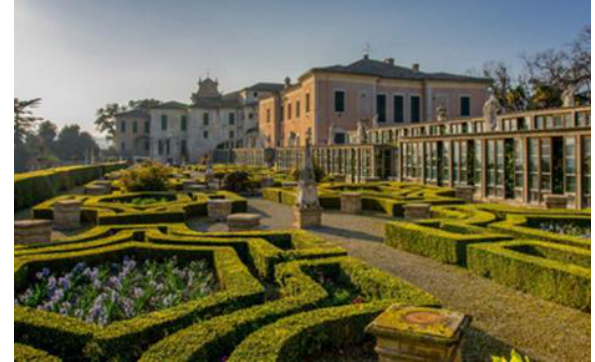
Figure 1. Villa Buonaccorsi and its typical Italian Garden